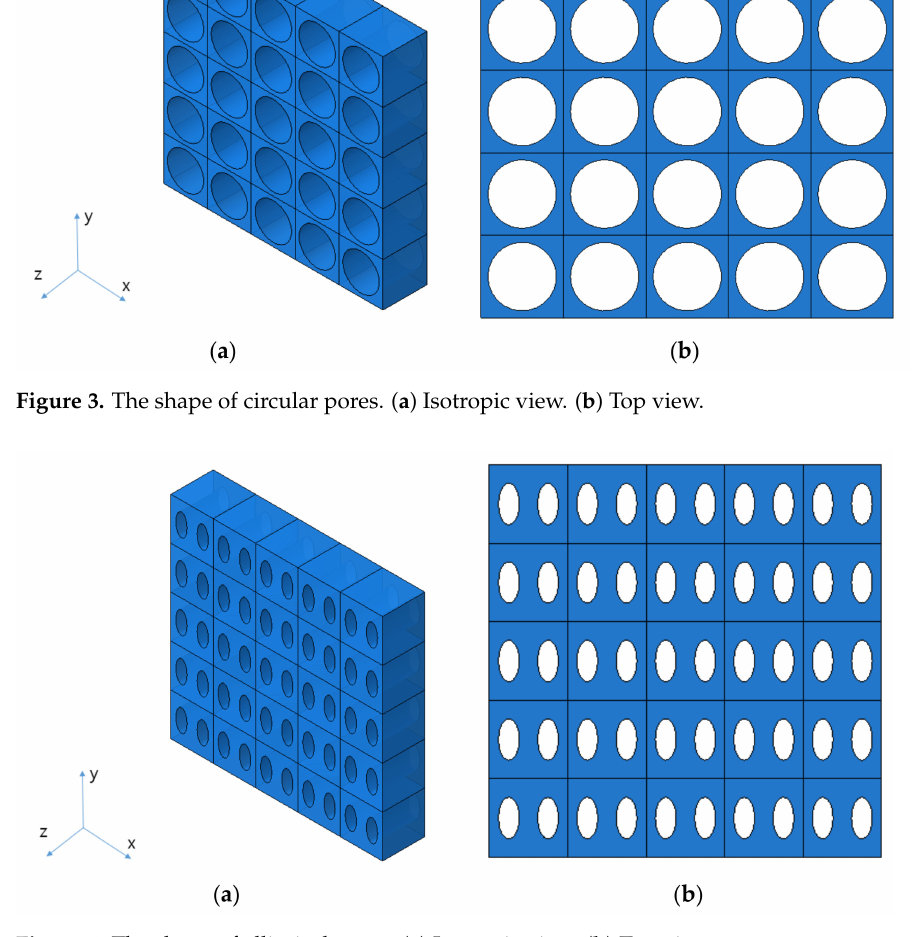
Figure 4. The shape of elliptical pores. ( a ) Isotropic view. ( b ) Top